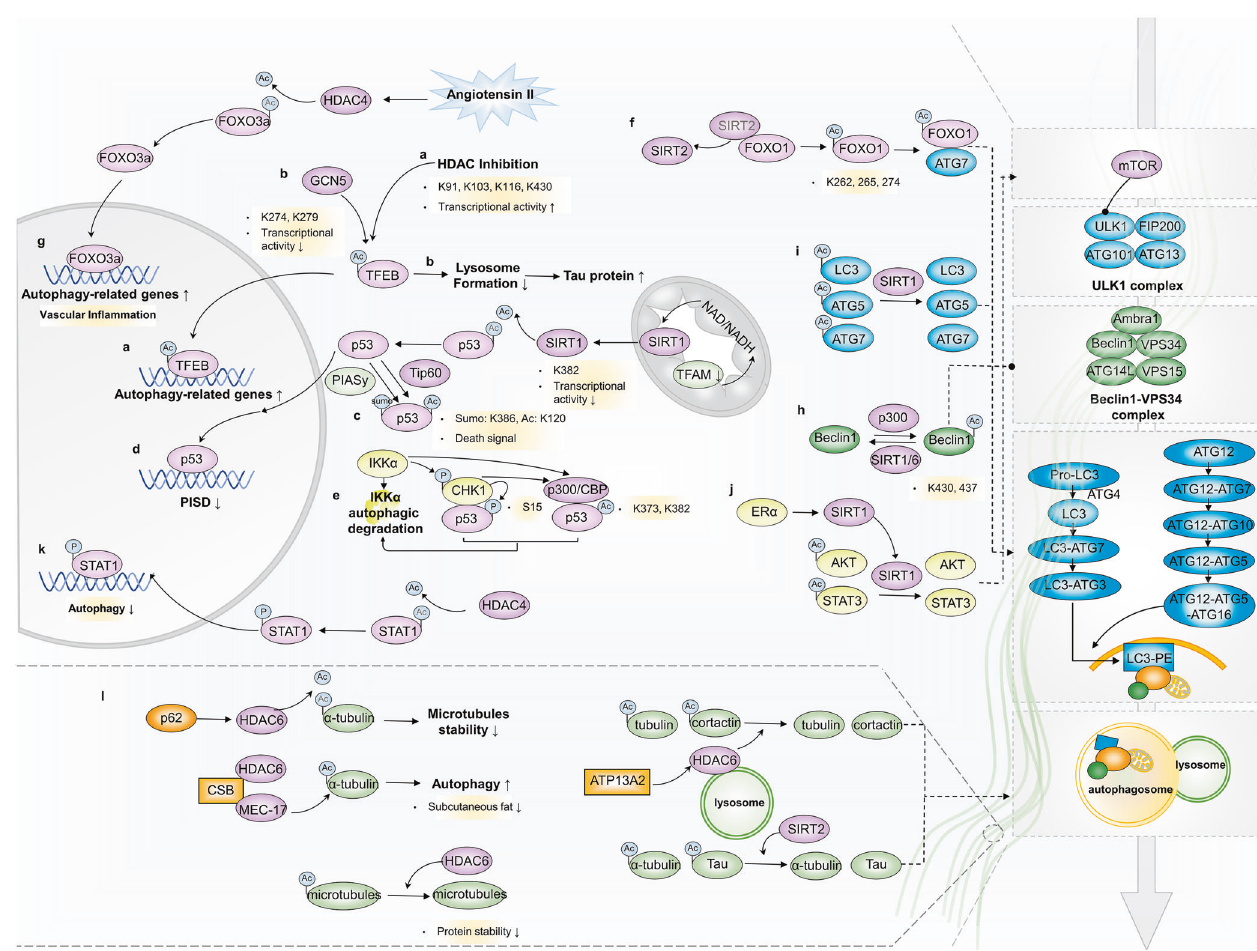
Fig. 5 Acetylation modi fi cation and autophagy regulation. a TFEB acetylation at K91, K103, K116, and K430 markedly activates the expression of its target genes related to autophagy and lysosomal biogenesis and induces cell death. b GCN5-catalyzed K274 and K279 acetylation of TFEB impedes lysosome formation and the clearance of Tau protein aggreagates. c Tip60-mediated p53 acetylation at K120 and K386 sumoylation function as a death signal to promote p53 cellular accumulation and autophagy. d P53 acetylation at K382 sites affects autophagy levels via the transcriptional regulation of the PISD enhancer. e P53 is phosphorylated by CHK1 activation and undergoes p300/ CEP-mediated acetylation at the K373 and/or K382 sites, which triggers autophagy and autophagy-mediated IKK α degradation. f Cytoplasmic FOXO1 is acetylated at K262, K265, and K274 via SIRT2 dissociation, facilitating the interaction between cytosolic FOXO1 and ATG7 and the autophagic process. g Upregulated HDAC4 deacetylates FOXO3a to transcriptionally activate autophagy. h P300 and SIRT1/6-regulated acetylation of Beclin1 at the K430 and K437 sites. i SIRT1 overexpression deacetylates LC3, ATG5 and ATG7 and activates autophagy. j ER α - induced SIRT1 expression deacetylates and activates AKT and STAT3, resulting in suppression of autophagy via mTOR-ULK1 and p55 cascade. k HDAC4-STAT1 signaling-regulating autophagy inhibition. (l) HDAC6-mediated cytoskeleton proteins acetylation